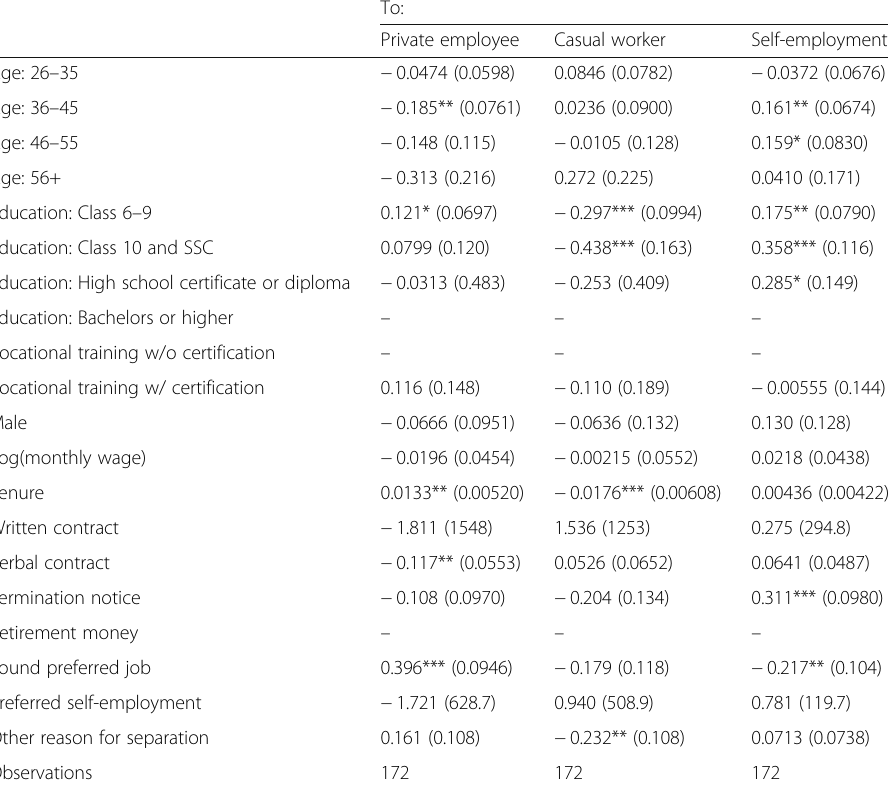
Table 12 Transitions from casual employment (marginal